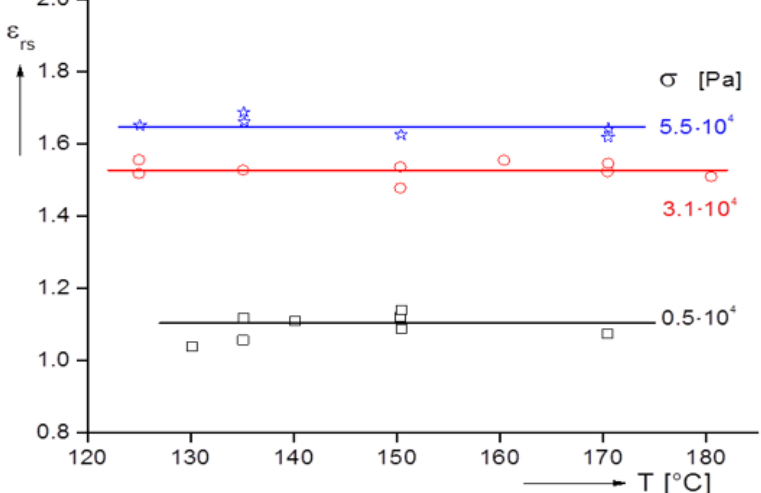
Figure 3. Recoverable elongation ε rs and recoverable compliance D rs in the steady state as functions of tensile stress from creep and stressing experiments for a polystyrene at 130 ◦ C [7].